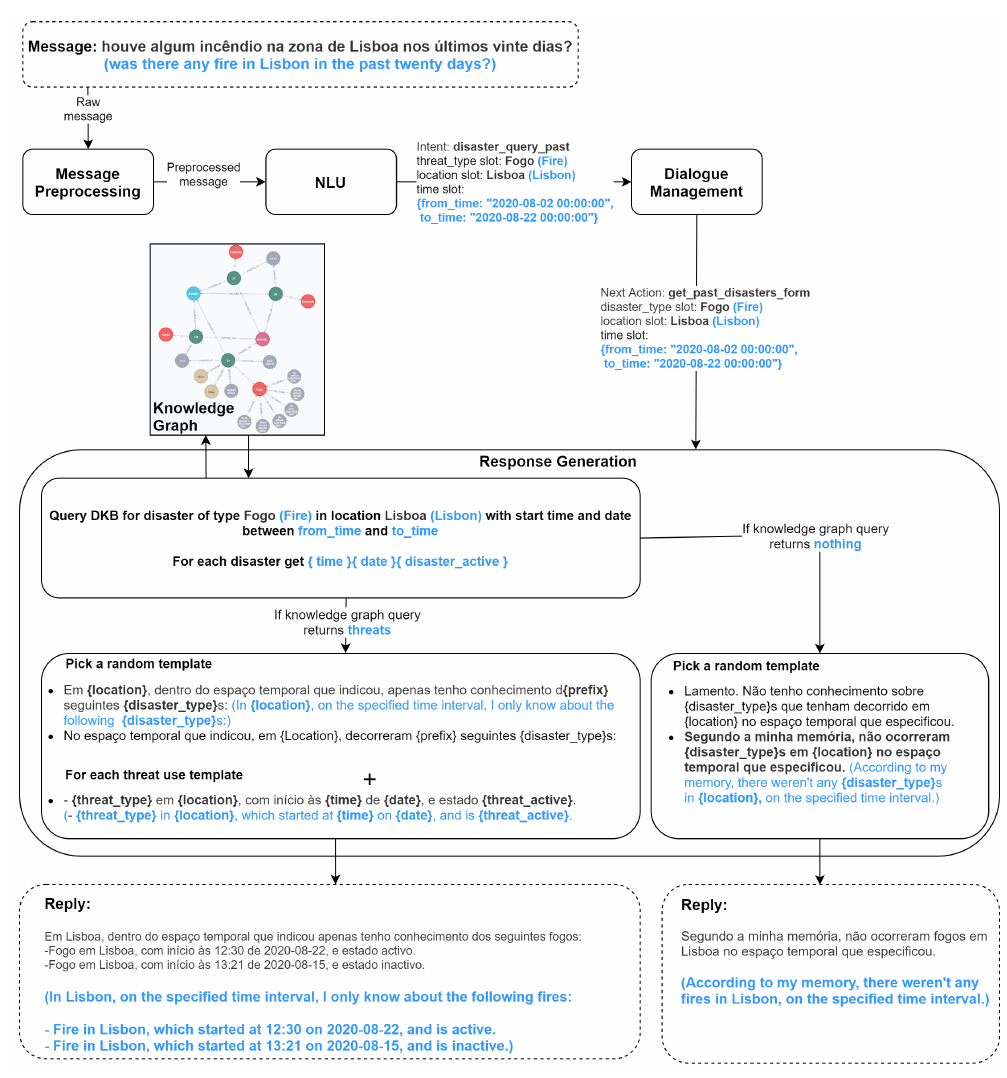
Figure 3. Chatbot response generation for the get_past_disasters_form action.